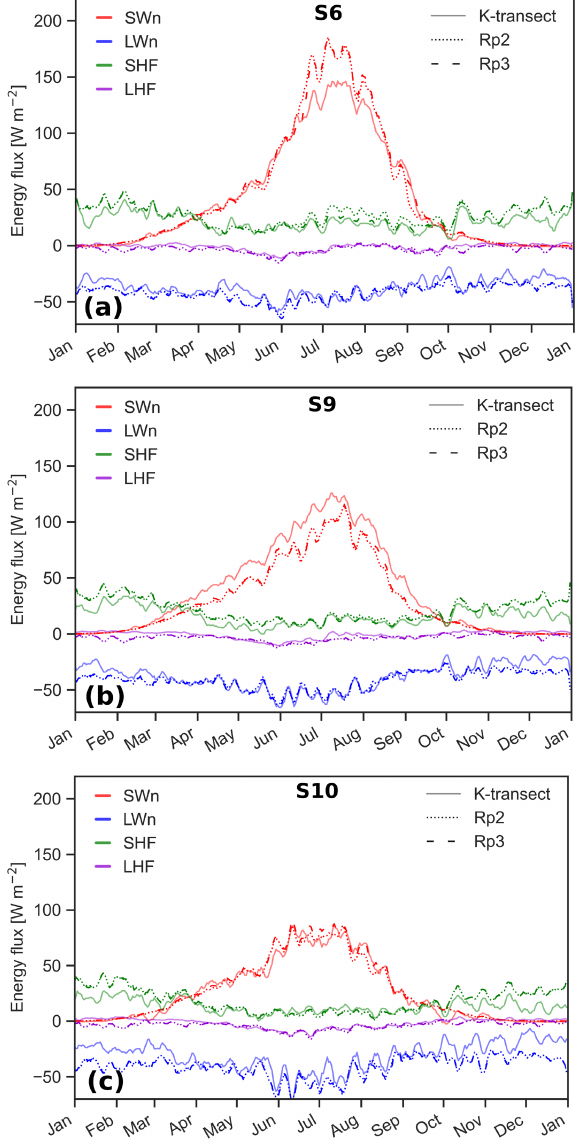
Figure 7. 2006–2015 averages of the 5d running mean SEB com- ponents for the K-transect for in situ observations, Rp2 and Rp3 at (a) S6 and (b) S9, and for 2010–2015 at (c) S10.